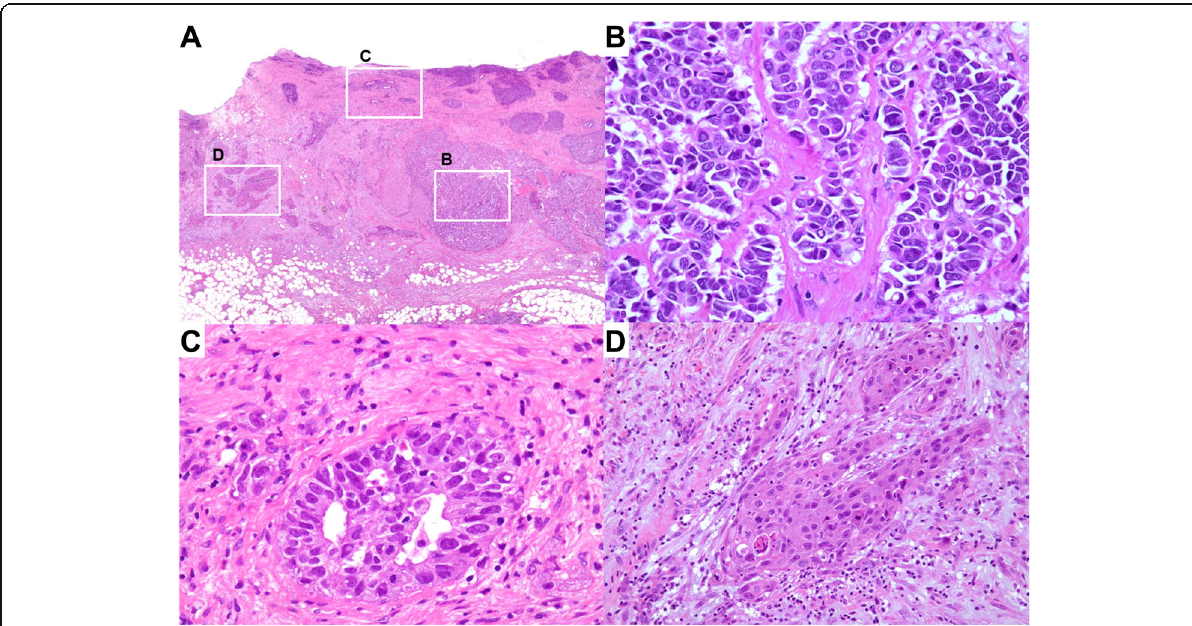
Fig. 5 Microscopic findings of the resected specimen with Hematoxylin-Eosin (HE) staining. a An NEC lesion was observed below the submucosal layer ( b ). An adenocarcinoma lesion was detected in the surface layer ( c ). The tumor partly showed squamous cell carcinoma ( d ). b NEC cells were dysplastic cells with a high N/C ratio and granular hyperchromatic irregular-shaped nuclei. c Adenocarcinoma lesion. d Squamous cell carcinoma